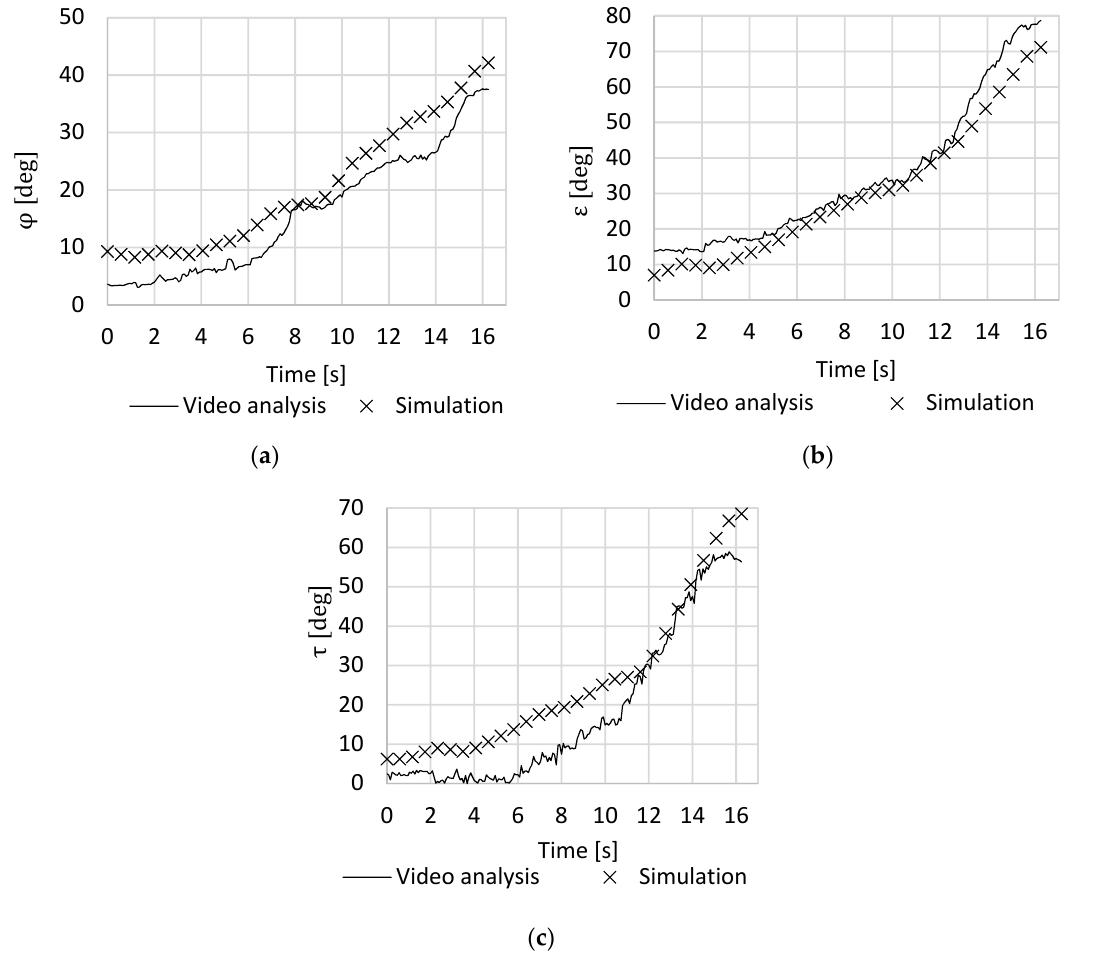
Figure 20. Comparison of finger joint angles in the prototype test (continuous line) and simulation (x marks): ( a ) angle φ versus time; ( b ) angle ε versus time; ( c ) angle τ versus time. Appl. Sci. 2020 , 10 , x FOR PEER REVIEW